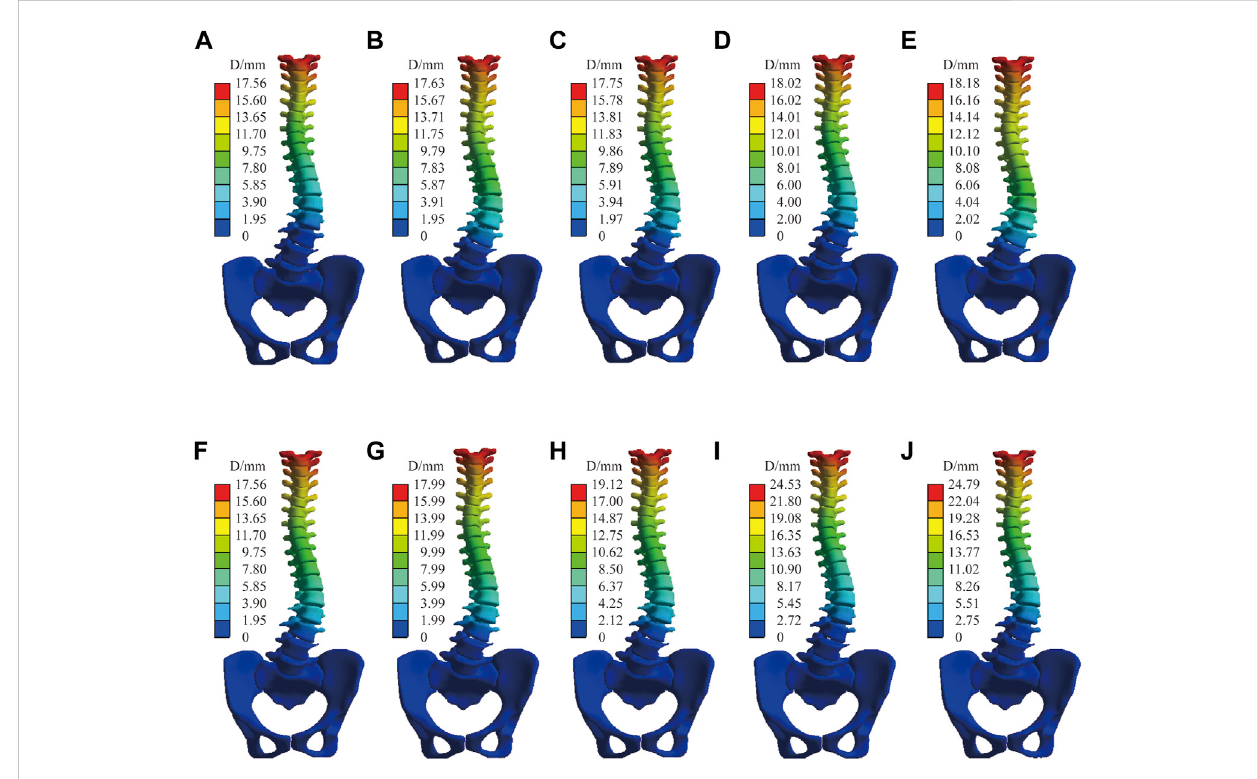
FIGURE 6 Spinal displacement distribution under C1. Bone control group: (A) Stiff intervertebral disk. (B) Transition intervertebral disk 1. (C) Normal intervertebraldisk. (D) Transitionintervertebraldisk2. (E) Flexibleintervertebraldisk.Intervertebraldisccontrolgroup: (F) Osteoporosisvertebralbody. (G)